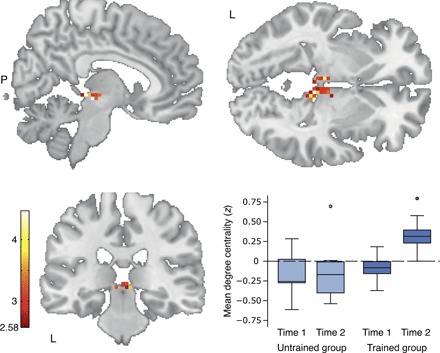
Learning to read modifies subcortical network centrality.Whole-brain degree centrality map thresholded at z = 2.58 (P < 0.005, corrected for cluster size) with corresponding color bar indicating the range of z scores. The effect of literacy instruction is depicted as a group (reading-trained individuals versus untrained illiterates) by time (before versus after intervention) interaction. The significant cluster stretches from the right superior colliculus of the brainstem (MNI coordinates: +6, −30, −3) to the bilateral pulvinar nuclei of the thalamus (MNI coordinates: +6, −18, −3; −6, −21, −3). The box plot resolves the interaction by separately showing the individual mean z values for each factor level. Mean degree centrality values of the untrained group did not differ significantly from zero (time 1: t1,8 = 1.76, P = 0.116; time 2: t1,8 = 1.10, P = 0.302; one-sample t tests).